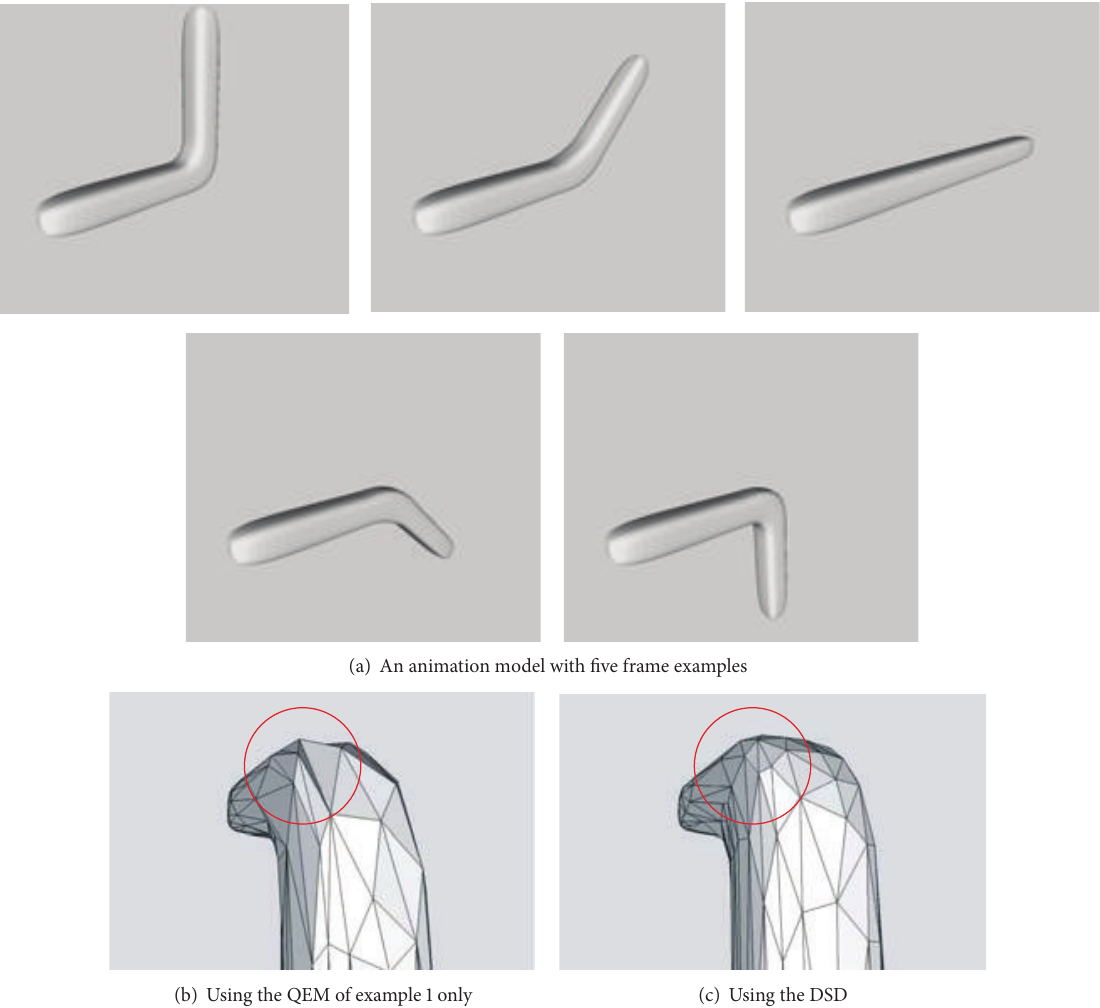
Figure 3: Simplification comparison between using the QEM of the first frame example and using the DSD